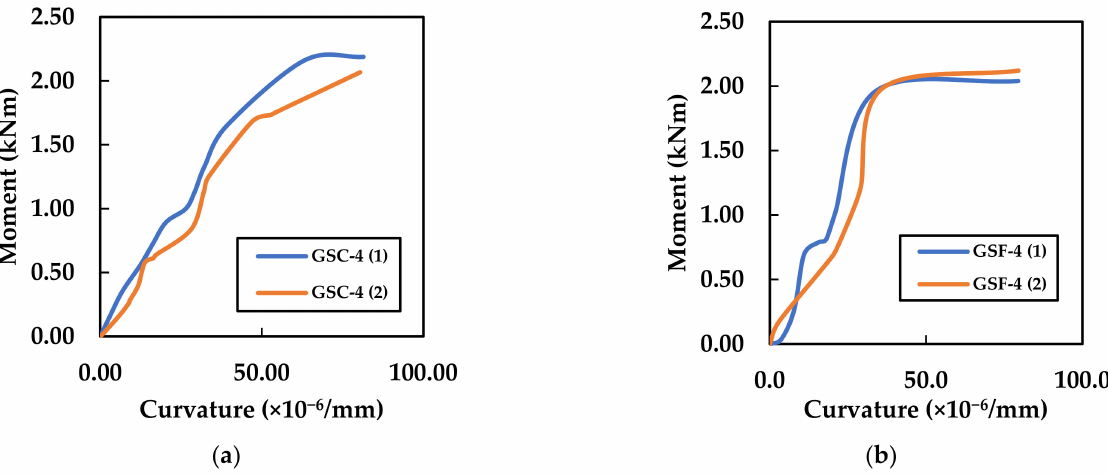
Figure 18. Moment–curvature behaviour of ( a ) GSC-4 and ( b ) GSF-4.